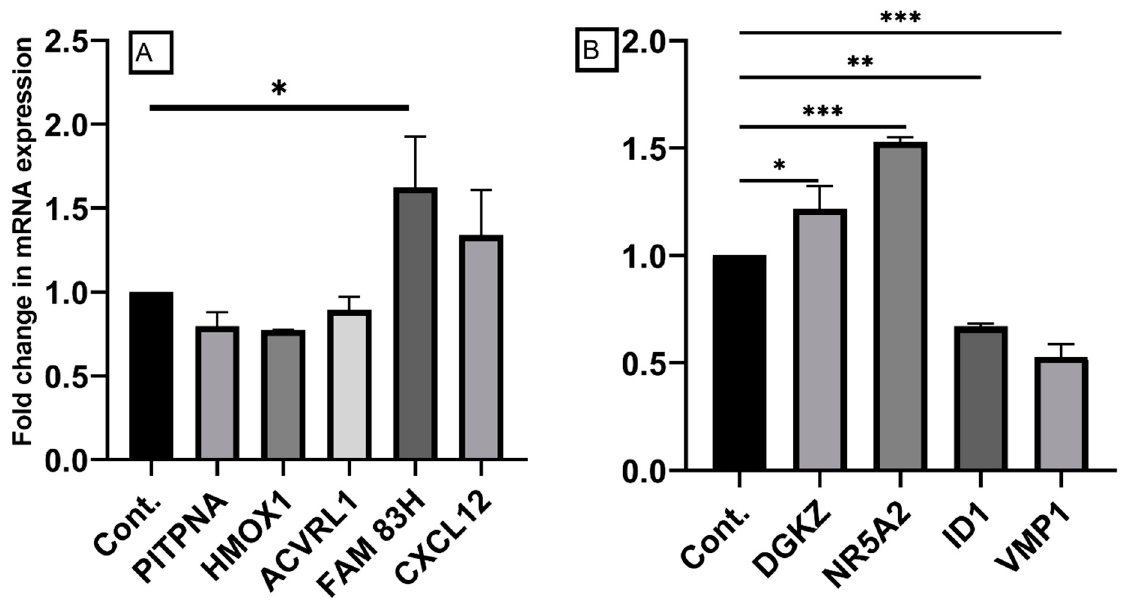
Figure 5. Confirmation of the differentially expressed genes by qRT-PCR. The figure shows the normalized relative expression of the test gene vs. the vehicle (DMSO)-exposed control. ( A ) The HCoEpiC cells, and ( B ) the HCT116 cells. Gene expression was determined using real-time quantitative reverse transcription PCR. Values are represented as means ± SEMs, with n = 3 (3 biological × 3 technical). * p < 0.05, ** p < 0.01, and *** p < 0.001.